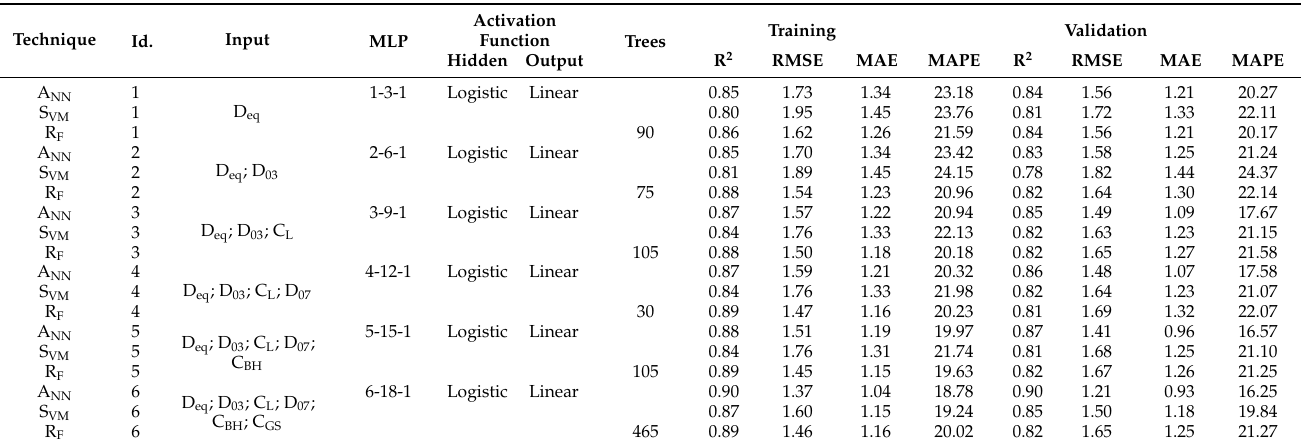
Table 5. Configurations of the machine learning techniques analyzed and model performance criteria used to predict crown diameter.